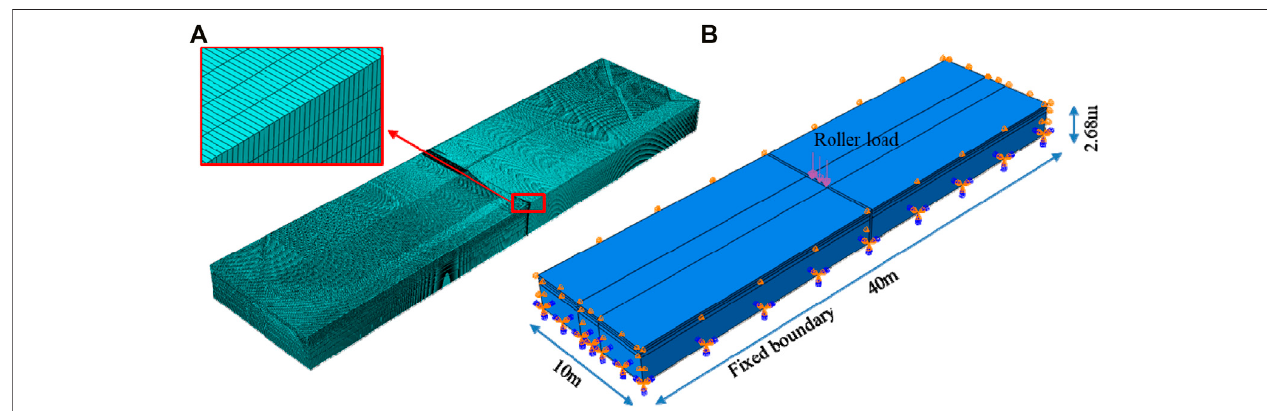
FIGURE 2 | FEM model: (A) meshing and (B) geometric and boundary conditions.